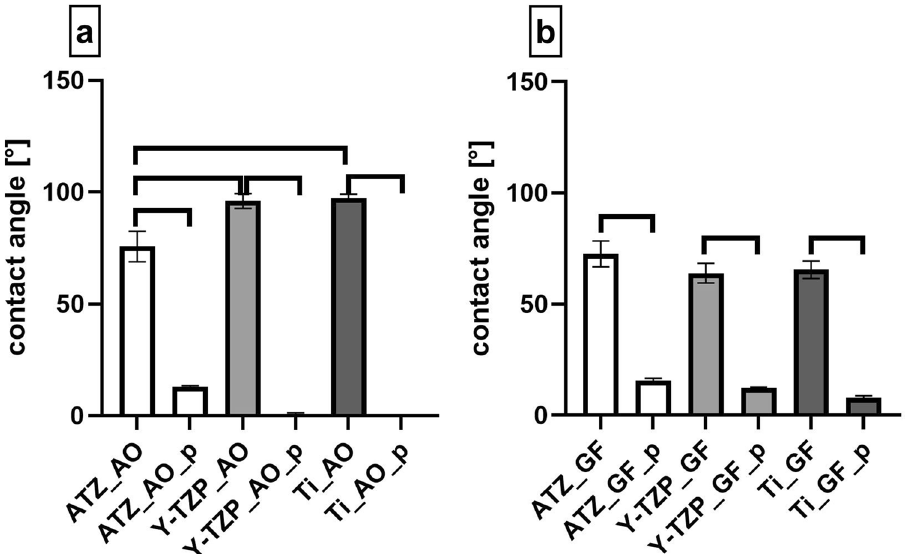
Figure 5. Characterization of biomaterial surface wettability by contact angle measurement. ( a ) Biomaterials intended for osteoblast cultures. ( b ) Biomaterials intended for fibroblast cultures. Graphs show mean values (n = 8) ± SEM. Statistically significant differences ( p < 0.05, Tukey´s HSD test) were marked with brackets above the corresponding bars.